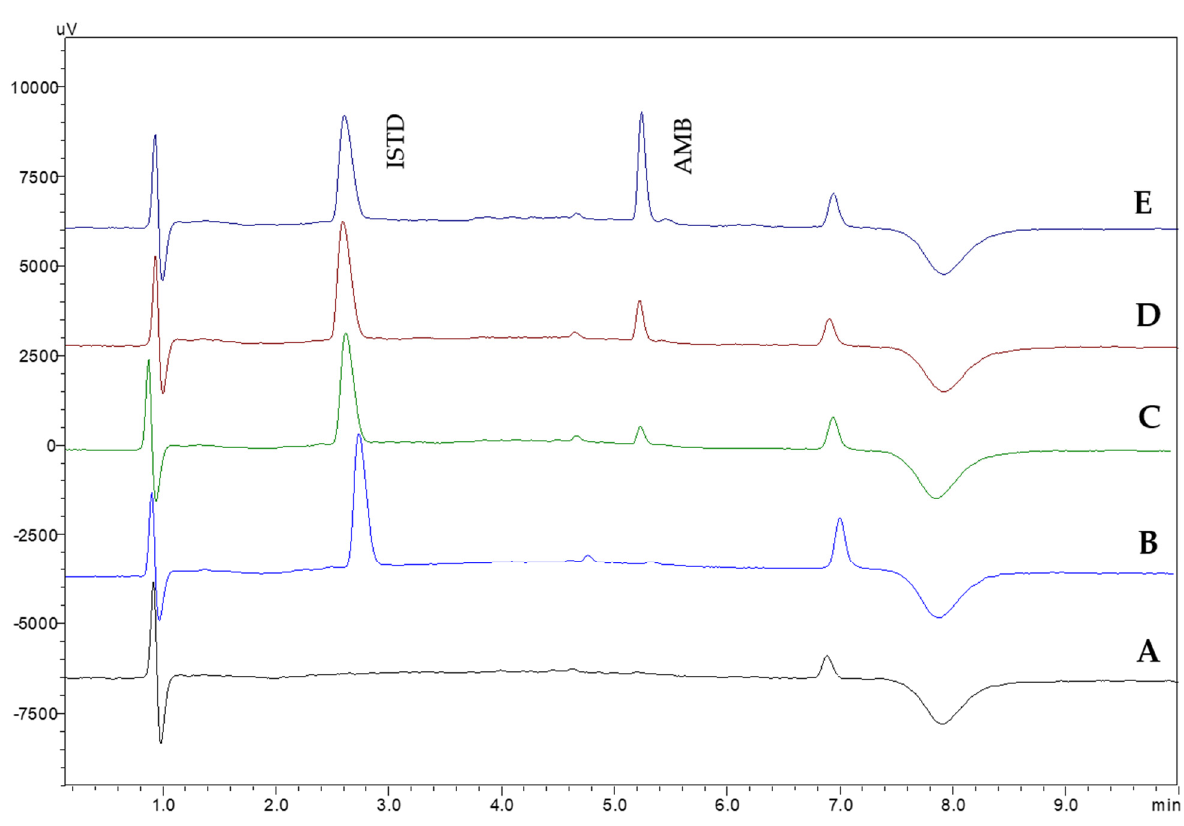
Figure 5. Representative chromatograms of the analysis of (A) blank serum and spiked with (B) ISTD, (C) ISTD and AMB (0.25 µ g mL − 1 ), (D) ISTD and AMB (0.50 µ g mL − 1 ), and (E) ISTD and AMB (1.0 µ g mL − 1 ) using the proposed CPME-HPLC-UV method. c(ISTD): 20 µ g mL − 1 .